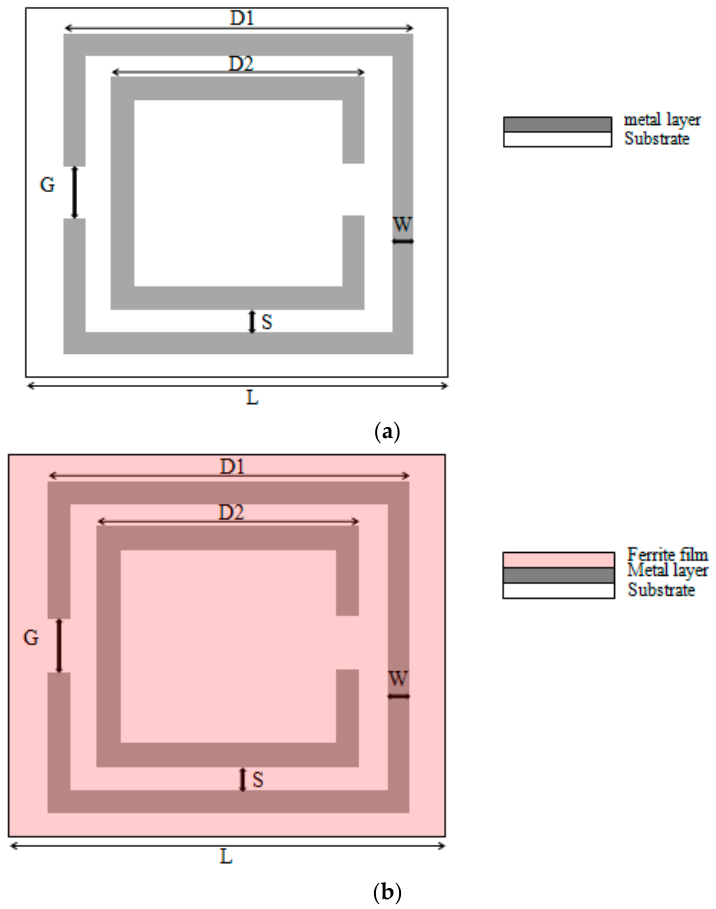
Figure 2. Schematics of the split ring resonator (SRR). ( a ) The metal conductive traces are on the dielectric substrate. The unit cell size is 25 mm × 25 mm; ( b ) The metal conductive traces are on the dielectric substrate. Another layer of ferrite film is attached on the metal layer. The unit cell size is 25 mm × 25 mm. D1: outer length of the SRR; D2: inner length of the SRR; G: split width in the rings; W: width of the ring trace; S: distance between the rings; L: unit cell size; t: thickness of the substrate; ε : The permittivity of the substrate.